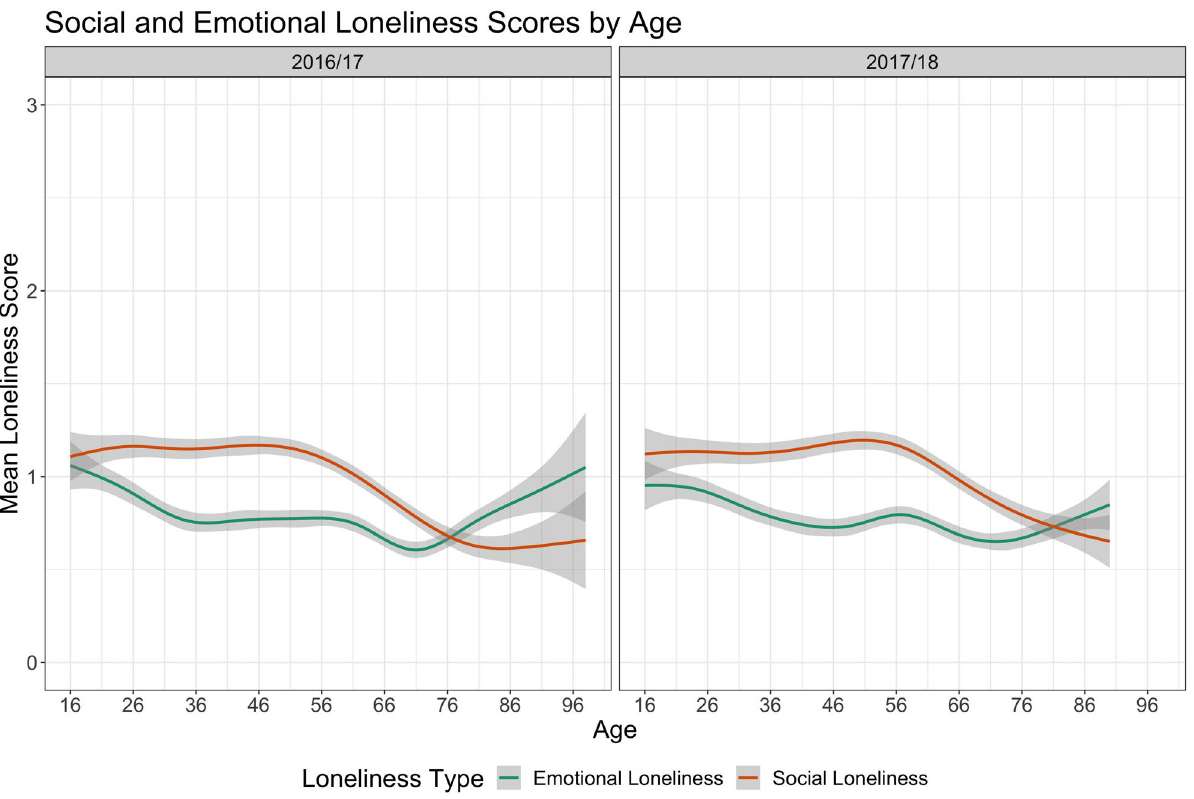
Figure 2. Mean social and emotional loneliness scores across the adult lifespan in the two NSW cohorts (2016/17 and 2017/18), along with 95% confidence intervals for each loneliness type. Scores for each loneliness type range between 0 (no loneliness) to 3 (severe